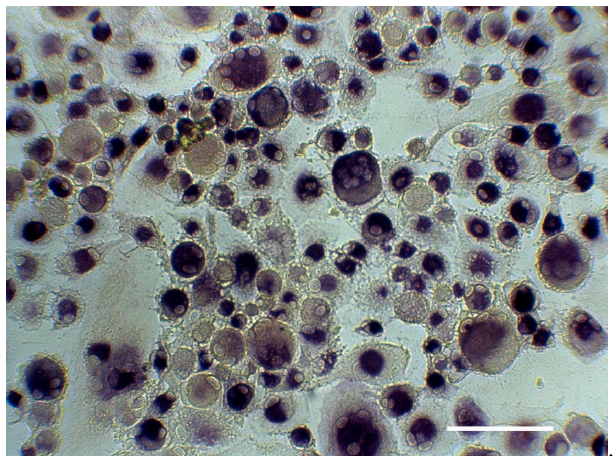
Figure 1. Exemplary tartrate-resistant acid phosphatase(TRAP) staining. Osteoclasts were differenti-